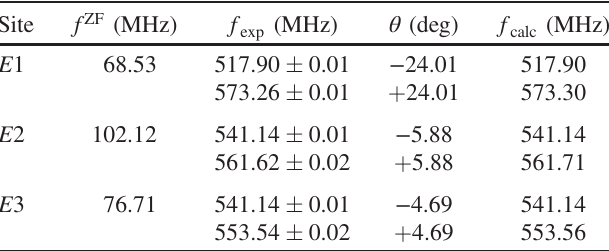
TABLE V. Comparison of frequencies f ¼ 4 T jj c and calculated values using Eq. (A1), 2 . 1 K in B ext ¼ 541 . 98 MHz and θ values that minimize j f f ext twice in f , as f − and f − exp E 2 E 3